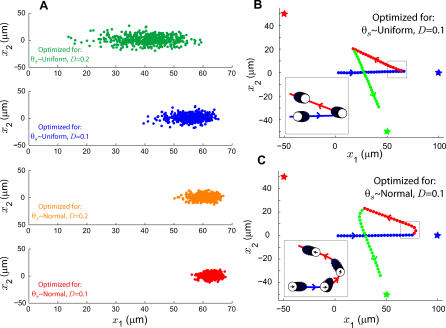
Chemotaxis Simulation for Cells Optimized under Various Gradient Assumptions(A) For each simulation, cells were initially at the origin (0,0) of a 2-D environment and exposed to a point source of attractant 100 μm to the right. Chemotaxis was simulated for 400 s and the cells' final position noted. Shown is the scatter plot of the final position of 500 cells employing the optimal stimulus–response map for a uniform source distribution with average distortion D = 0.2 (green), uniform source with D = 0.1 (blue), normal source with D = 0.2 (orange), and normal source with D = 0.1 (red). Final distance from the source for naïve cells: 60 ± 8 μm for D = 0.2, 45 ± 4 for D = 0.1; and 40 ± 3 for D = 0.2 versus 37 ± 2 for D = 0.1, for biased cells.(B,C) Mean trajectory of simulated cells employing the optimal stimulus–response map for uniform (B) and normal (C) source distributions with average distortion D = 0.1. Cells were exposed to an attractant source at location (100,0) at time 0 s (blue star) followed by a source at location (−50,50) at 500 s (red star) and (50, −50) at 900 s (green star). The dots indicate the average of 500 cell trajectories. The insets show the stimulus–response maps, as in Figure 2, at several points before and after a change in gradient source. For all simulations, position units are μm, cell velocity is 10 μm/min, and biased cells are optimized for a variance of
45°.